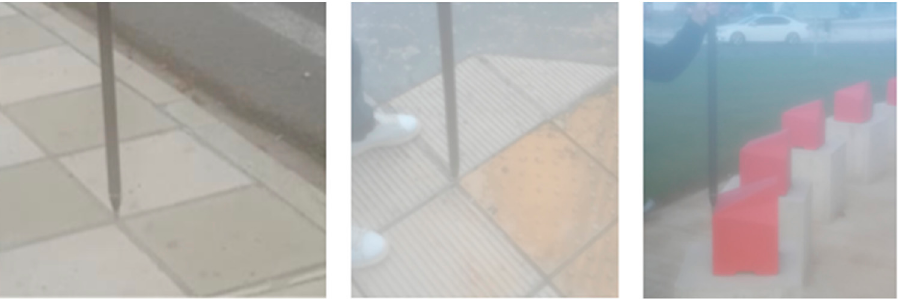
Figure 4. Natural ground control points.